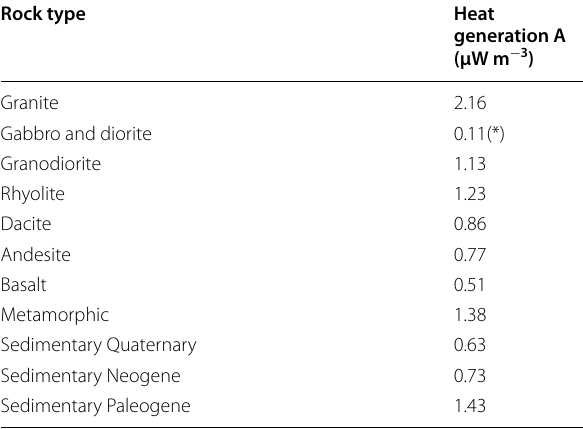
Table 6 Heat generation, A. Radiogenic heat value estimated based on Minato (2005). Based on Beardsmore and Cull (2001) for gabbro only Rock